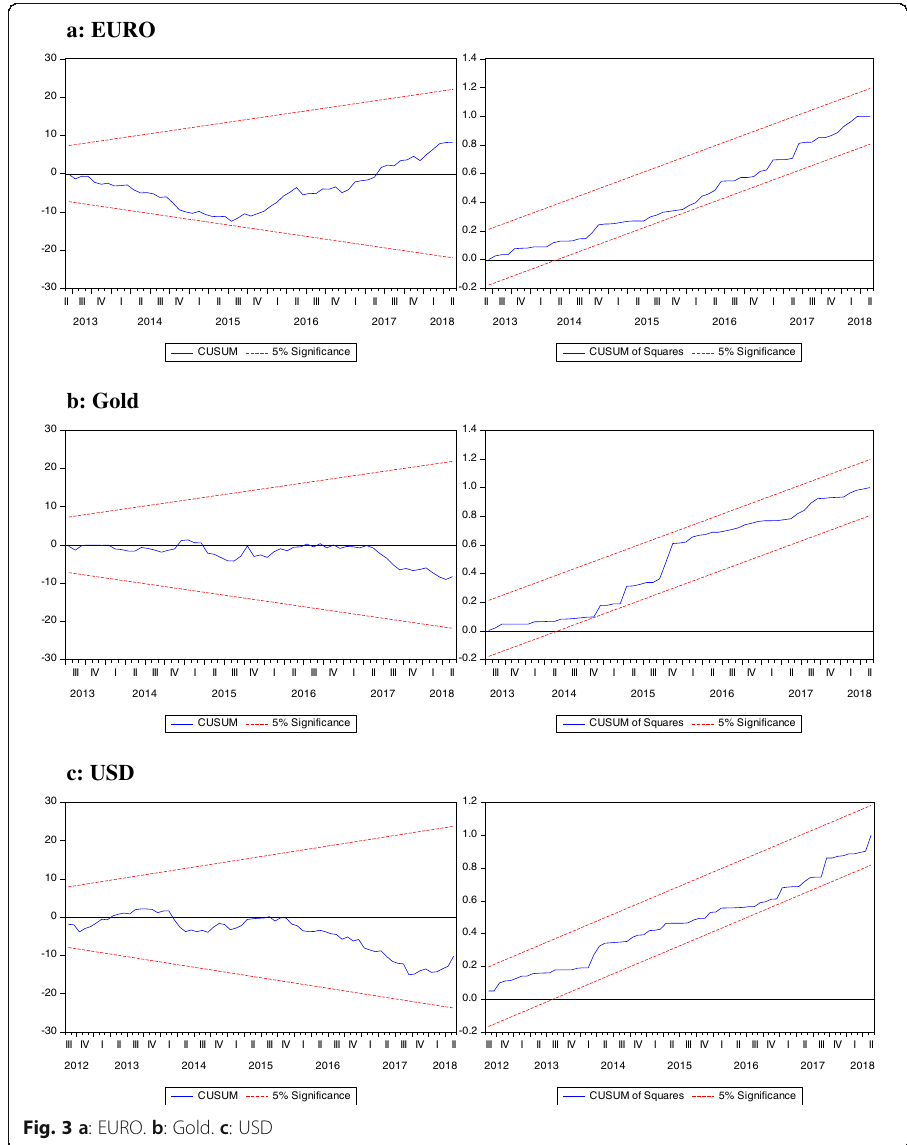
Fig. 3 a : EURO. b : Gold. c :